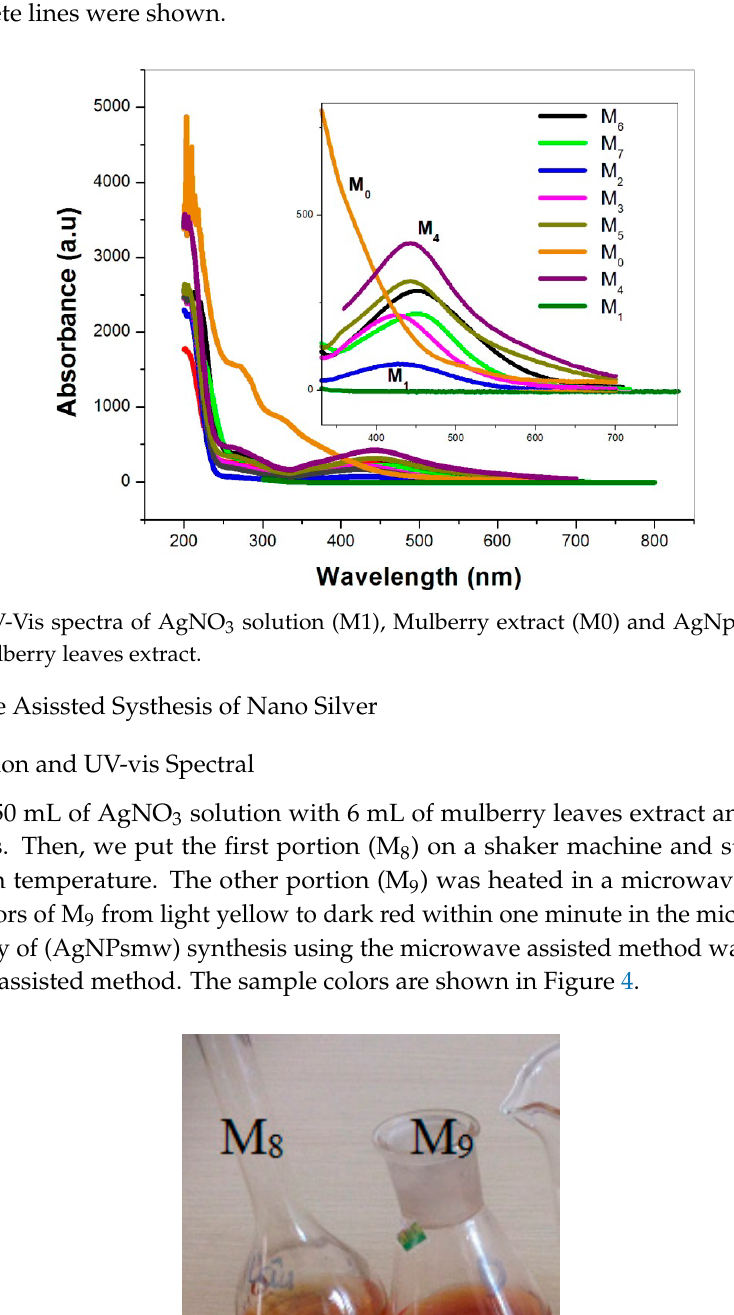
8 ) and of AgNPsmw (M 9